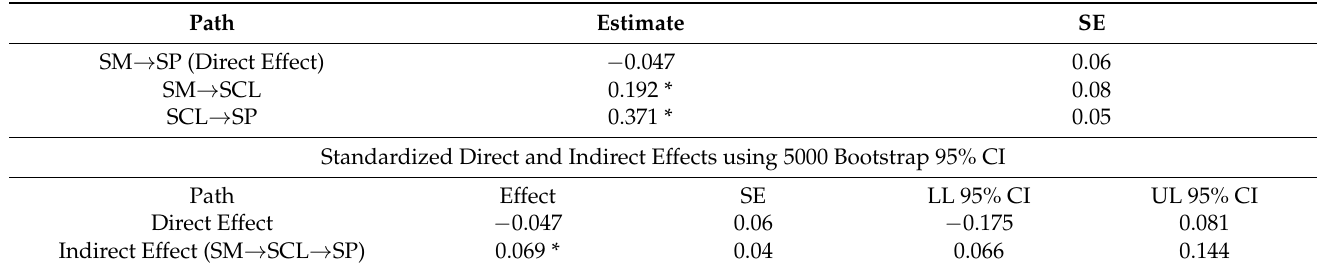
Table 4. Five thousand bootstrap results for direct and indirect effects. PROCESS Model 4 (safety climate as